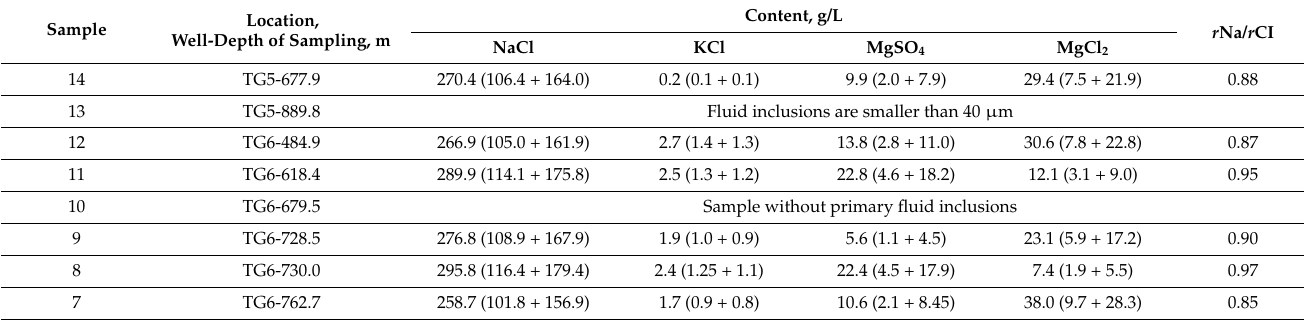
Table 1. The chemical composition of Tuz Gölü brines, and Cenozoic marine brines presented as salts (in the brackets sum of